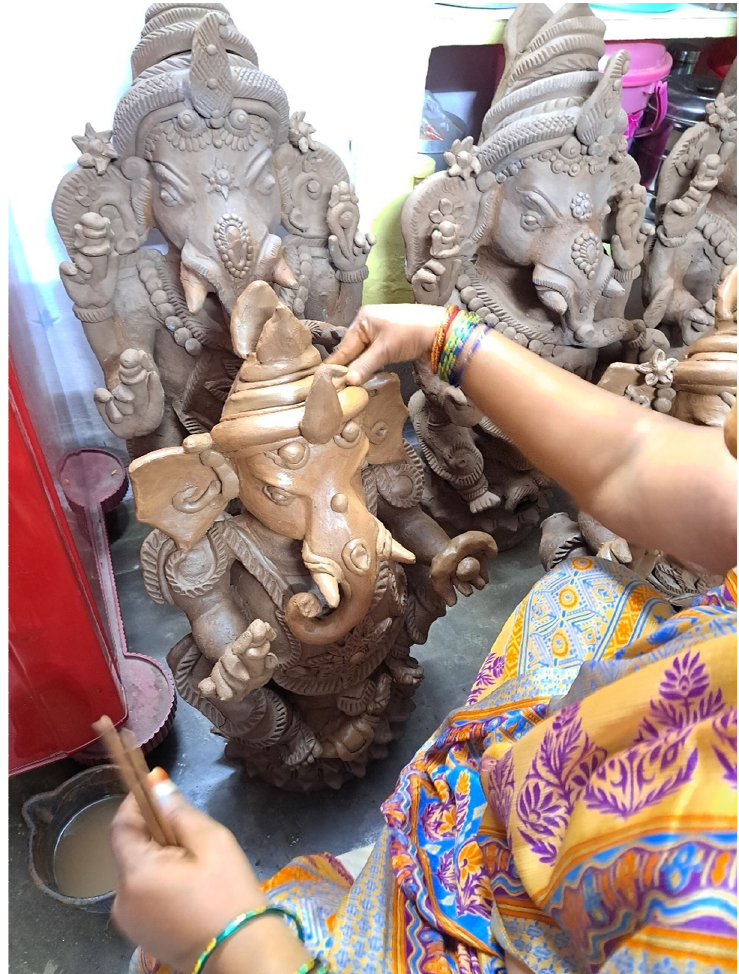
Figure 10. Hand manufacturing of clay Ganesha by pottery family in Vellore. Picture taken by author, 28 August 2022, Vellore.